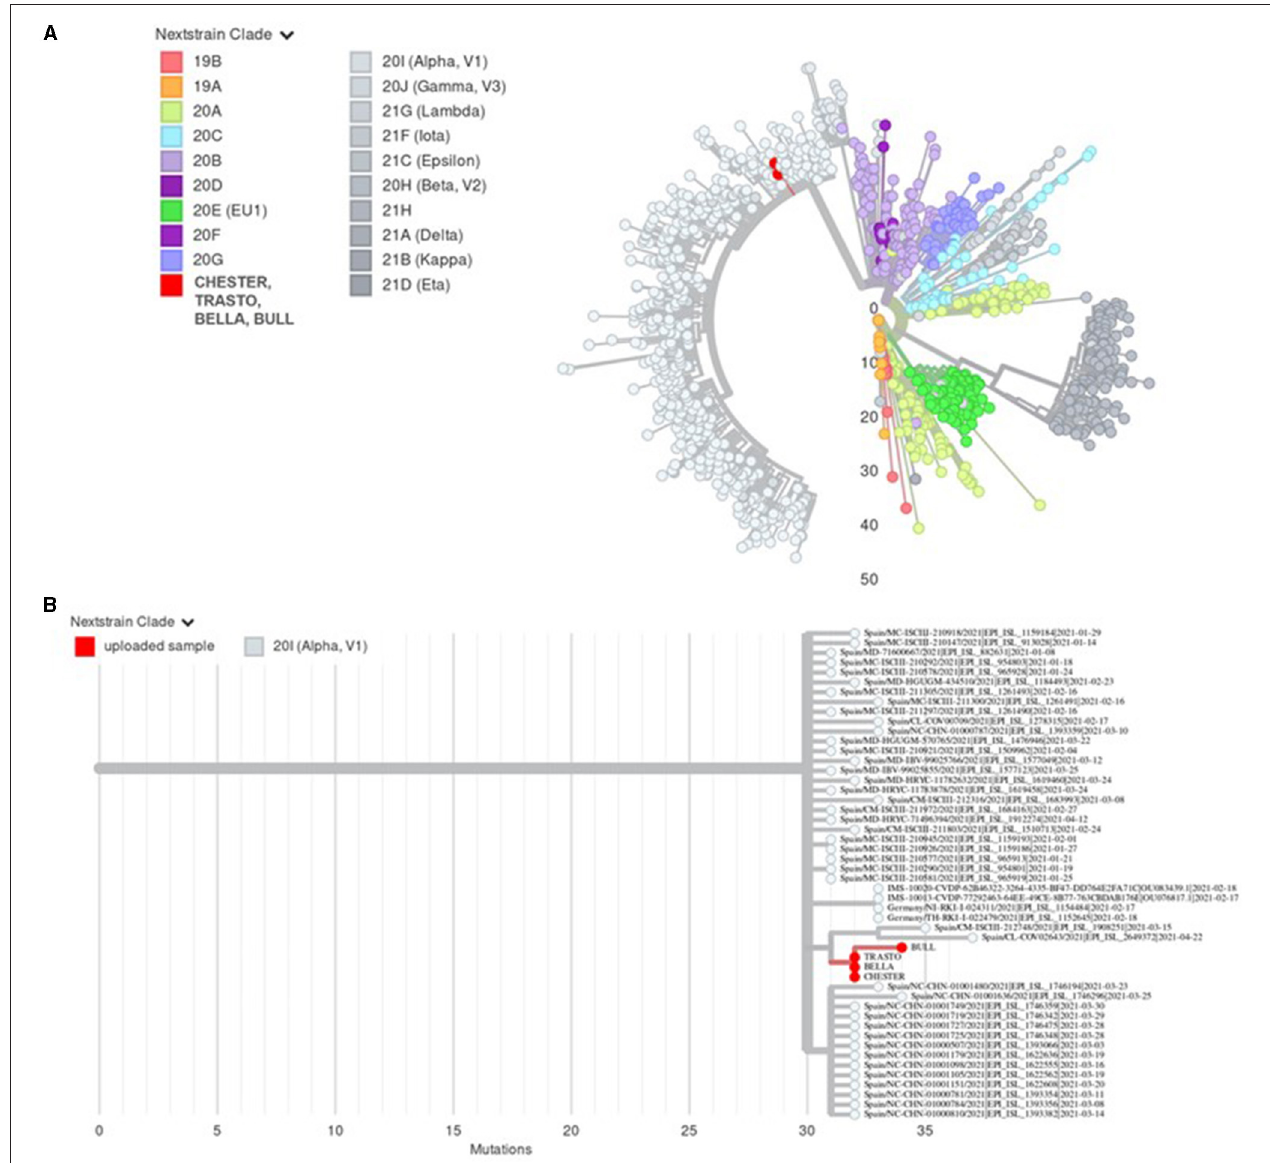
FIGURE 1 | (A) Phylogenetic analysis generated by UShER of the four SARS-CoV-2 cases described. The analysis includes 2,664,613 genomes from the GISAID, GenBank, COG-UK, and CNCB databases (updated July 30, 2021). Subtrees including case 1 (Chester), case 2 (Trasto), case 3 (Bella), and case 4 (Bull) sequences plus (a) 1,000 random sequences from the phylogenetic tree for context (radial visualization) or (b) 50 nearest sequences from the phylogenetic tree are shown. (B) Sequence comparison showing concordance, nucleic acid, and amino acid changes in the four sequences with respect to the SARS-CoV-2 Reference Sequence as reported in Genome Detective